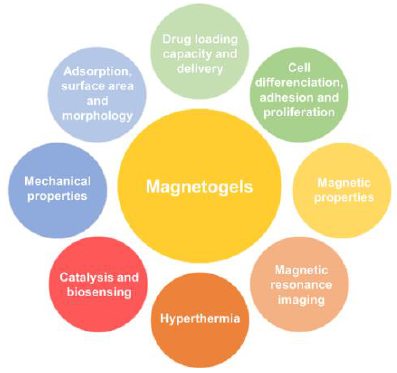
Figure 2. Introduced, tuneable and controllable properties and applications of magnetogels.